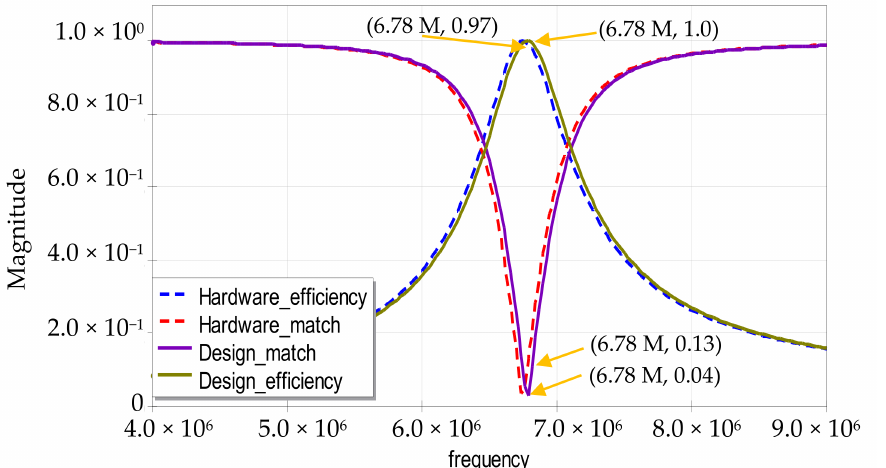
Figure 11. Efficiency and match impedance for the hardware and design value.